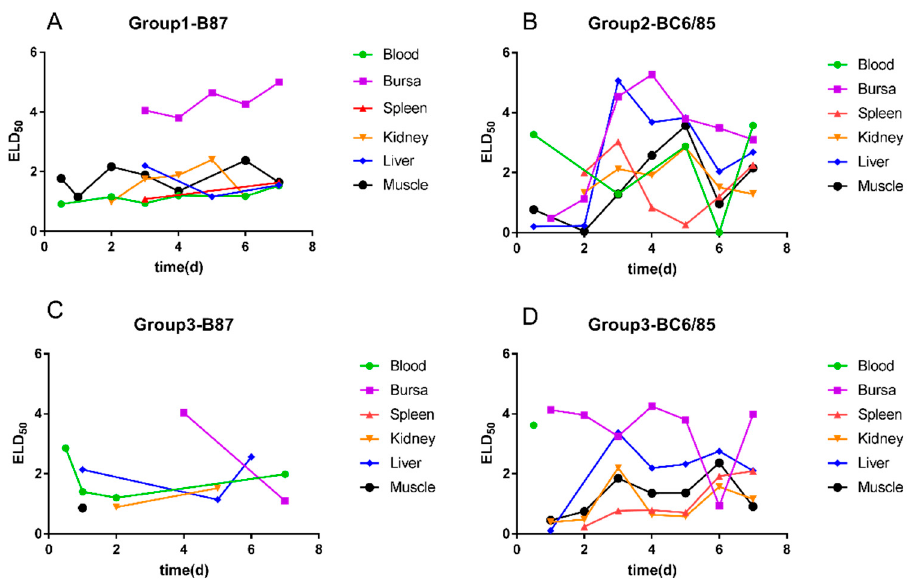
Figure 2. Viral loads of B87 and BC6/85 in bursa, spleen, liver, kidney, blood, and muscle of SPF chickens infected with B87 and (or) BC6/85. ( A ) B87 in Group 1; ( B ) BC6/85 in Group 2; ( C ) B87 in Group 3, spleen samples were all negative; ( D ) BC6/85 in Group 3.